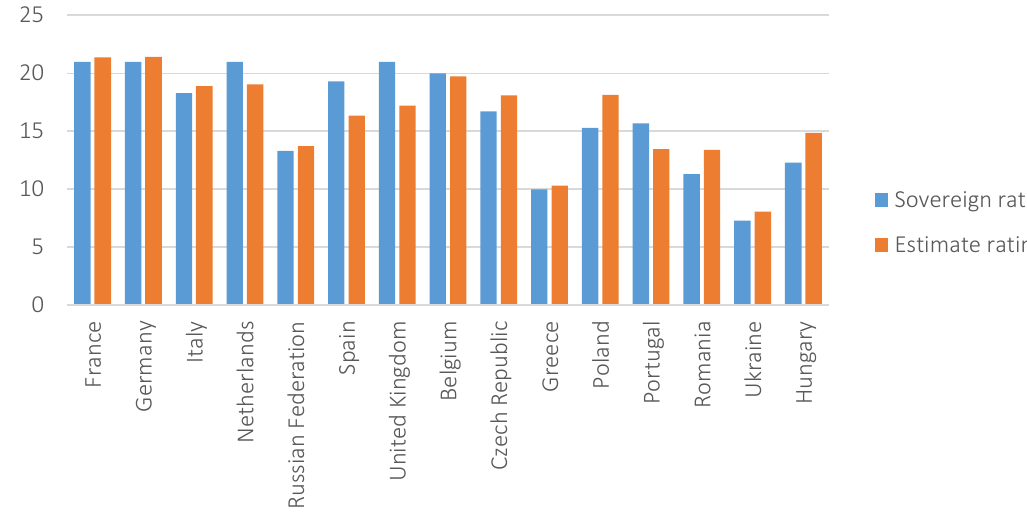
Sorce: Own processing and